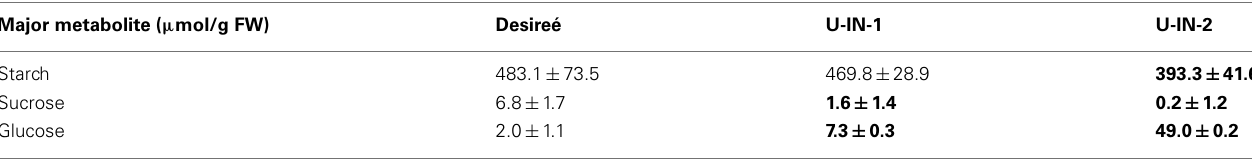
TableA3 | Major carbohydrates content of the different genotypes.